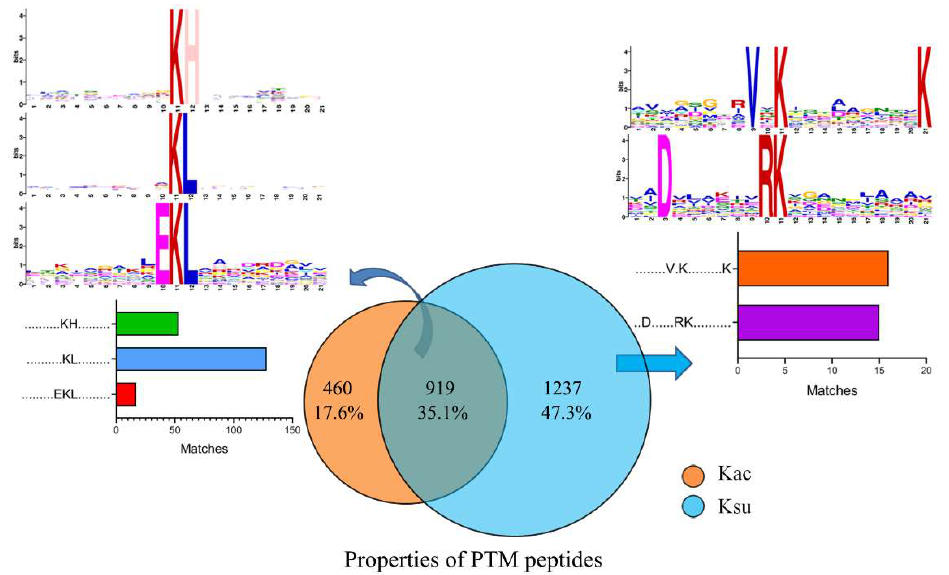
Figure 2. Motif analysis of acetylated and succinylated peptides in E. tarda . Venn diagram shows the overlapping peptides between the PTMs.